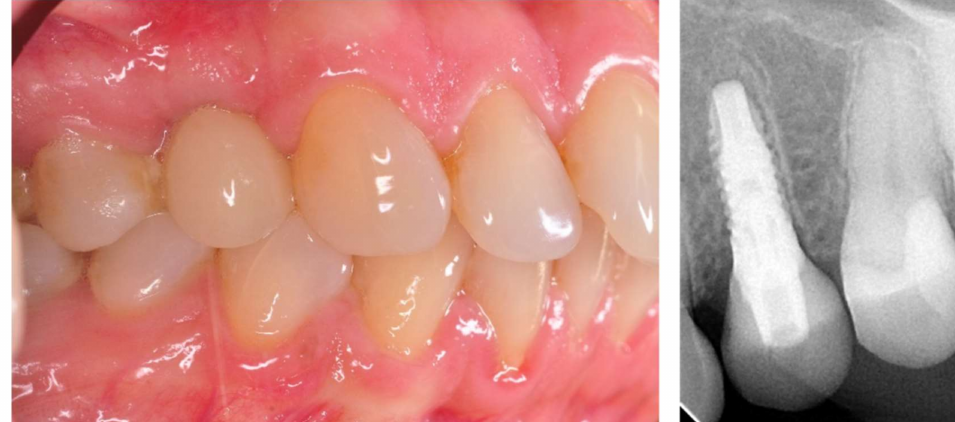
Figure 3. Implant loaded with the screw-retained